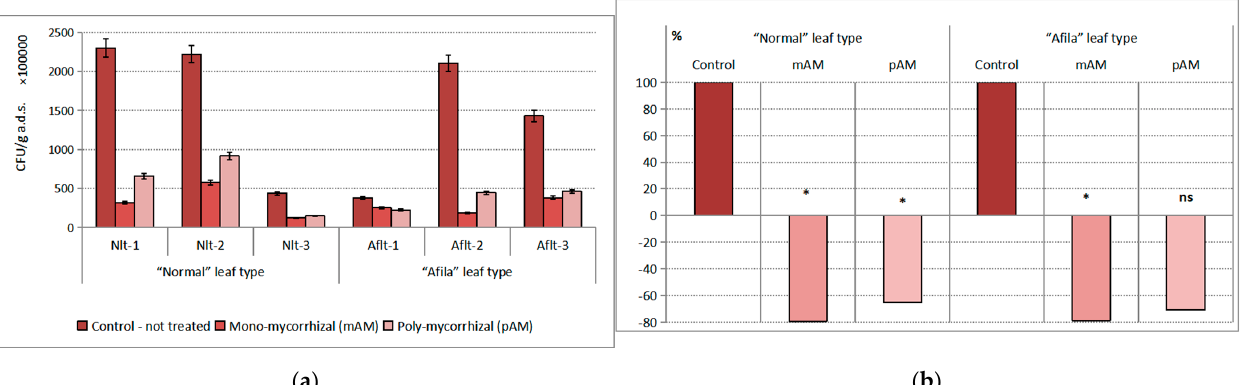
Figure 2. Average population density of the trophic group Actinomycetes (CFU ∙ g − 1 absolutely dry soil) in the rhizosphere communities formed after introduction of AM fungi: (mAM) mono-mycorrhizal and (pAM) poly-mycorrhizal inoculants. ( a ) Average values for the particular varieties of garden pea with “normal” leaf type (Nlt-1—cvr. Marsi, Nlt-2—cvr. Plovdiv and Nlt-3—cvr. 22/16-n) and “afila” leaf type (Aflt-1—cvr. 22/16-af, Aflt-2—cvr. Kazino and Aflt-3—cvr. Echo). Error bars indicate standard error of the mean (SE). ( b ) Relative values of the differences in the population levels of the trophic group Actinomycetes (%) compared to the untreated controls, including means for both “normal” leaf type and “afila” leaf type genotypes. The significance of the differences between means of controls and treatments were calculated with the two-tailed Student’s t -test (at df—10; * p < 0.10), ns—nonsignificant)